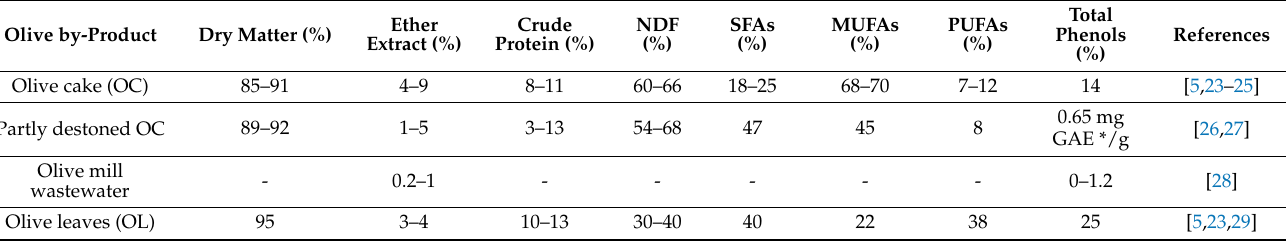
Table 1. Composition of the different olive by-products for feeding